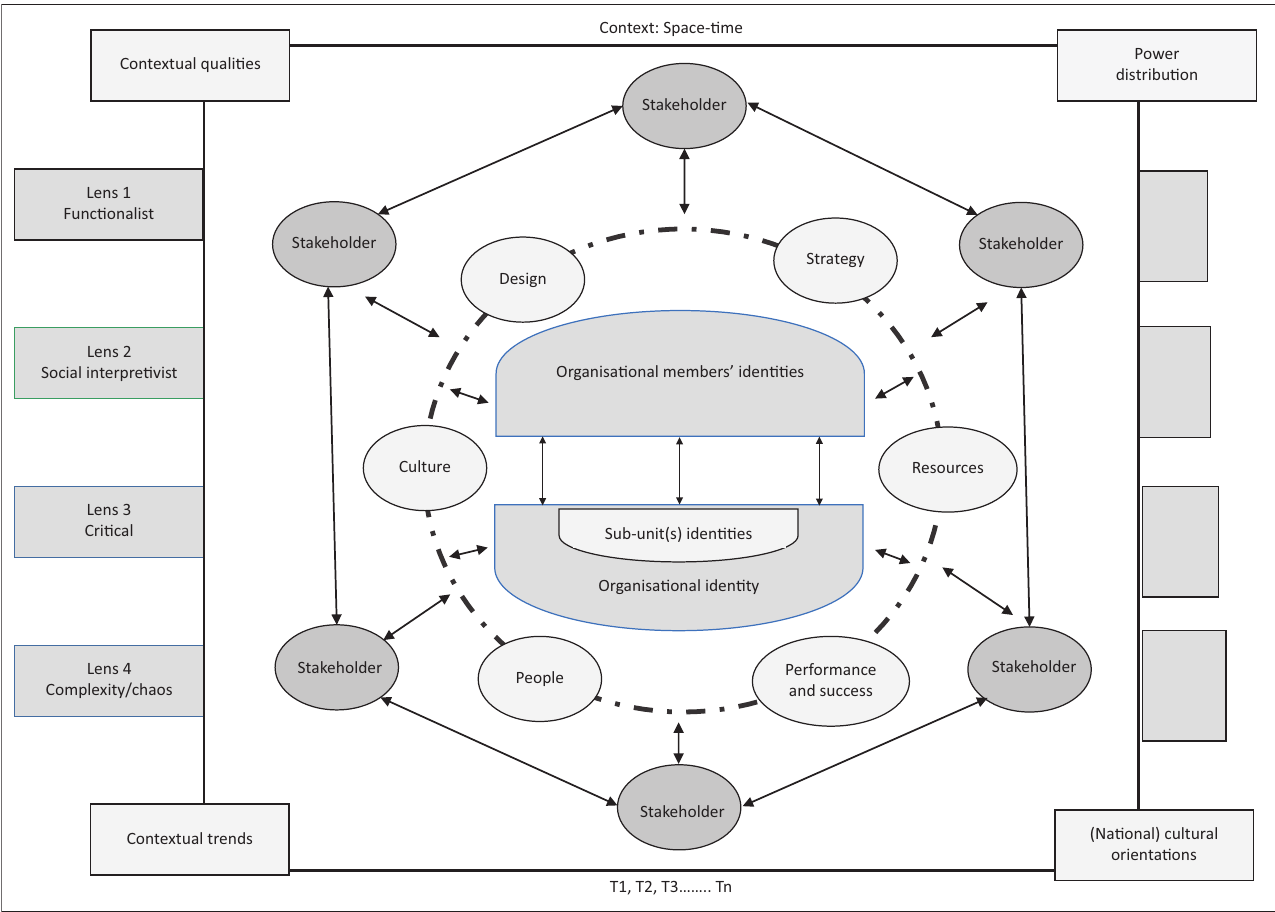
FIGURE 1: Proposed Organisational Identity Landscape as meta-theoretical framework to map the territory called ‘Organisational